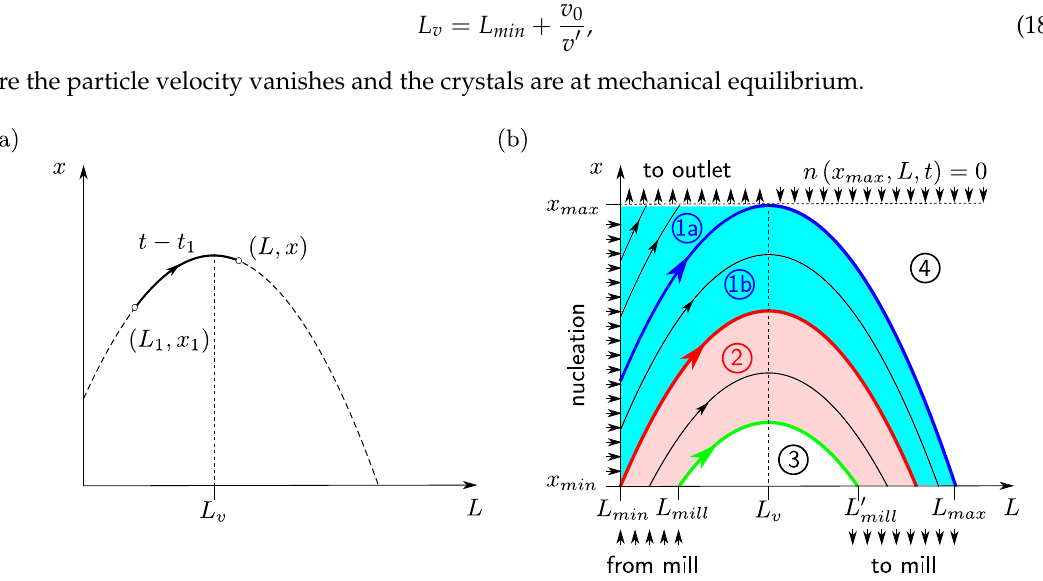
Figure 3. Characteristic curves in the L - x -plane for a particle velocity according to (14). ( a ) Single characteristic indicating the path of a fluid element from point ( L 1 , x 1 ) to point ( L , x ) ; the arc length is equal to the time t − t 1 the fluid element needs from one point to the other. ( b ) Regions in the L - x -plane with qualitatively different behavior of the crystals; region (1) contain crystals generated by nucleation, which either escape through the crystallizer top (1a) or sink to the bottom (1b); region (2) contain crystals generated in the mill and returning to the mill; regions (3) and (4) are free of crystals. The thick green line corresponds to the crystals with the shortest residence time, the thick blue line to those with the longest residence